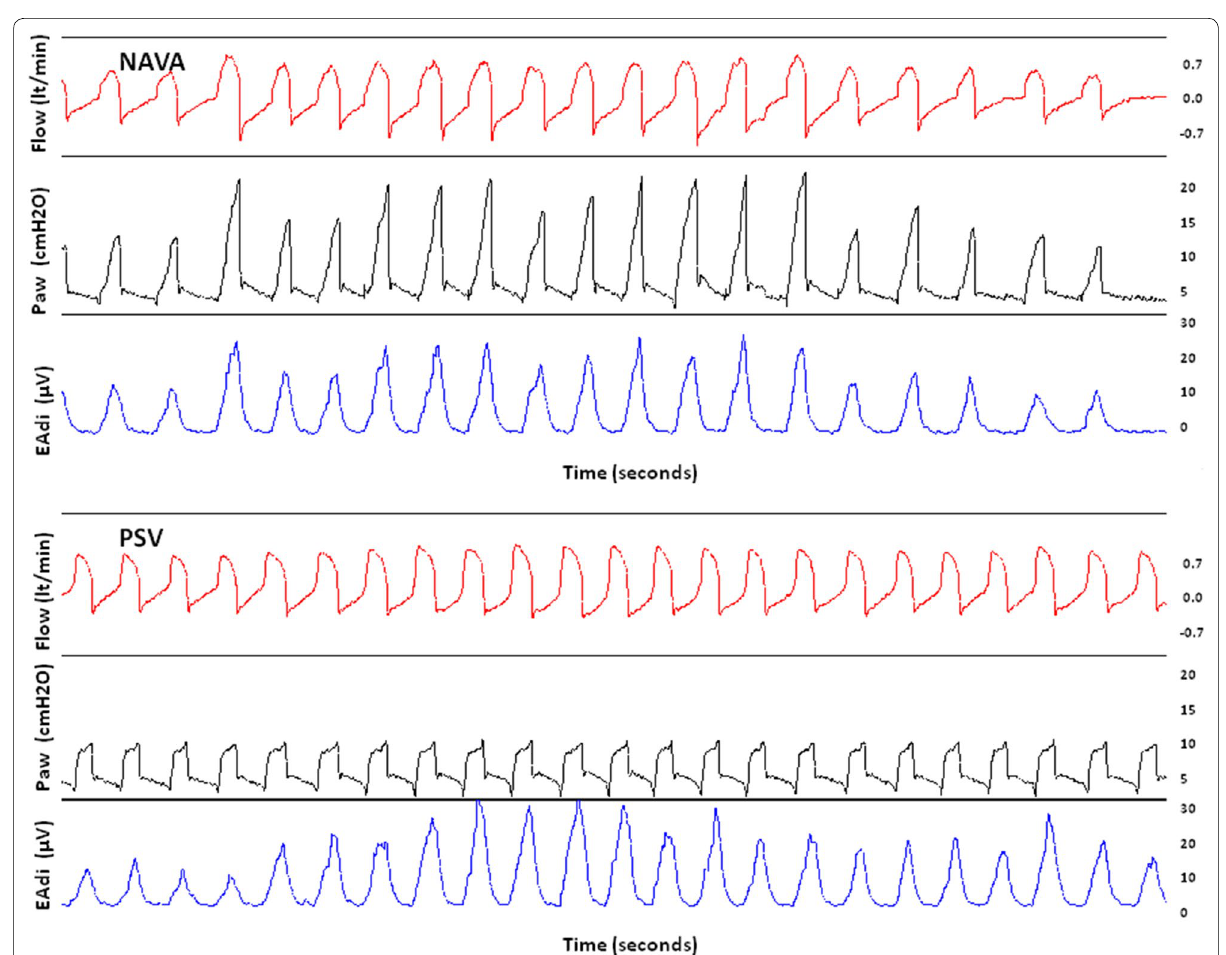
Fig. 2 Recordings of Flow, airway pressure (Paw) and electrical activity of the diaphragm (EAdi) during exercise in the same patient during two examined sessions: one with Neurally Adjusted Ventilator Assist (NAVA) and one with pressure support ventilation (PSV). During NAVA, one can observe the great variability of Flow due to changes in neural effort (reflected by changes in EAdi) which led to changes in delivered Paw. In con‑ trast, despite similar changes in EAdi during PSV, delivered Paw and Flow remained